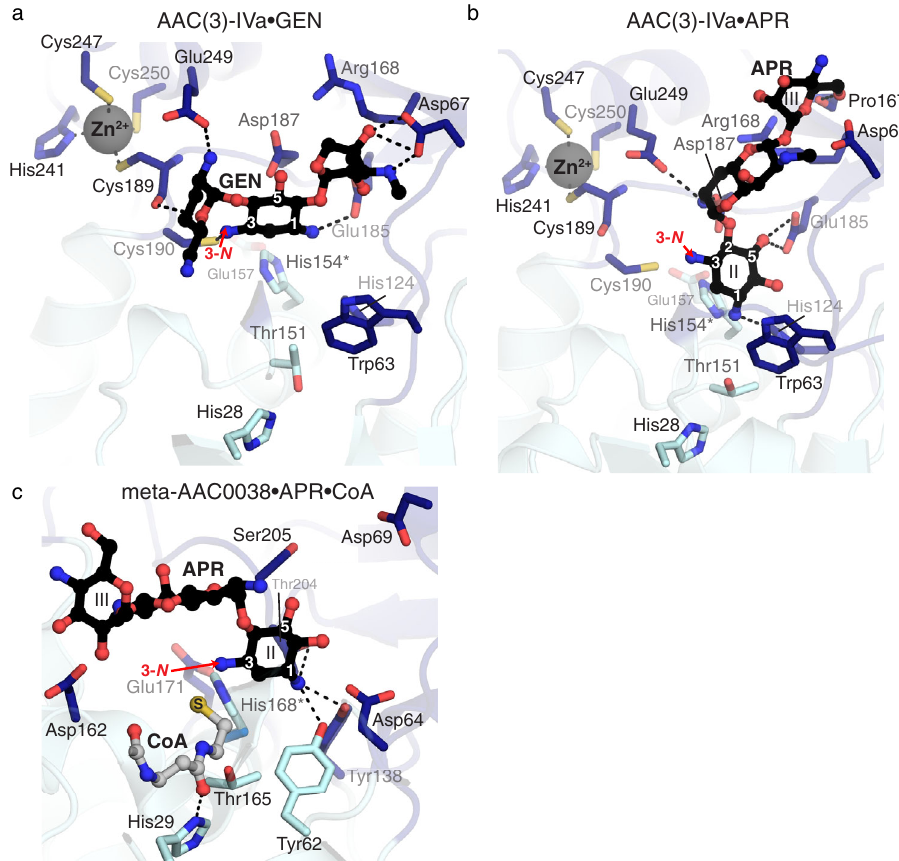
Fig. 4 Details of molecular recognition of aminoglycosides by meta-AAC0038 and AAC(3)-IVa. a From solved crystal structures, active sites of AAC(3)-IVa H154A and gentamicin, b AAC(3)-IVa H154A and apramycin, and c meta-AAC0038 H168A and apramycin and CoA. Dashes indicate hydrogen bonds. Since each protein was crystallized with inactive mutants, His168Ala of His154A mutations for meta-AAC0038 and AAC(3)-IVa, respectively, these sidechains shown in this fi gure are from the apoenzyme structures and indicated with asterisks. Residues colored in dark and light blue are from the major and minor subdomains of the two enzymes, respectively. Acetylation sites (3- N groups) are labeled with red